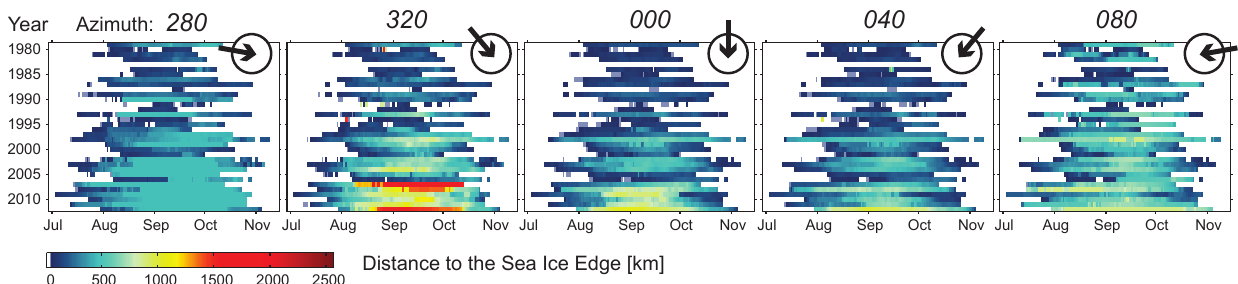
Figure 7. Distance to the sea-ice edge from Drew Point for the period 1979–2012. Both the length of the open-water season and the distance to the sea-ice edge have increased in this time period. The distance to the sea-ice edge has increased the most in the northwest direction, which is the direction from which wind blowing sets up nearshore water